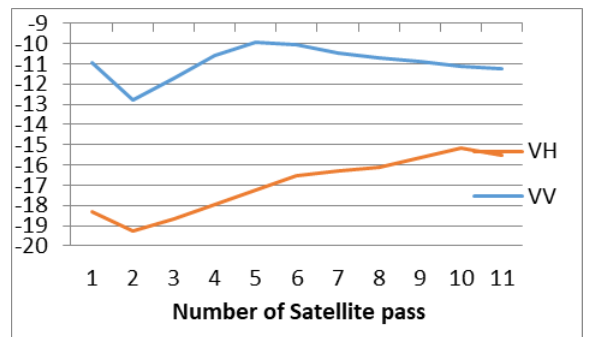
Fig.4. Average dB value of selected field for VV and VH